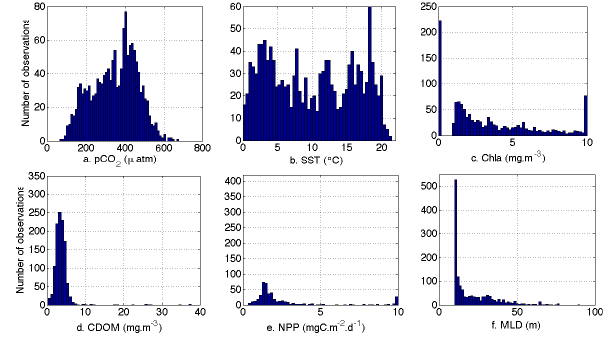
Figure 7. Histogram of (a) p CO 2 and satellite data, (b) SST, (c) Chl a , (d) NPP, (e) CDOM, and (f) MLD available for the SOM before reconstruction. Y axis represents the number of data, and the x axis the value of the parameters.